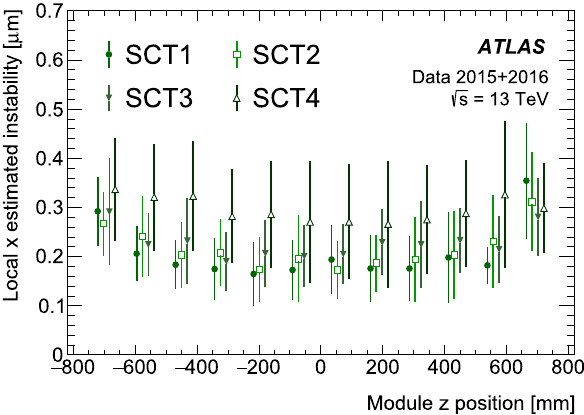
Fig. 15 Estimated σ time x as a function of module global- z position for SCT barrel layers. The vertical bar on each marker represents the standard deviation of the estimated value over modules at the same z - positionalongdifferentstaves.Theglobal- z positionisslightlymodified for the different SCT layers for visualisation purposes